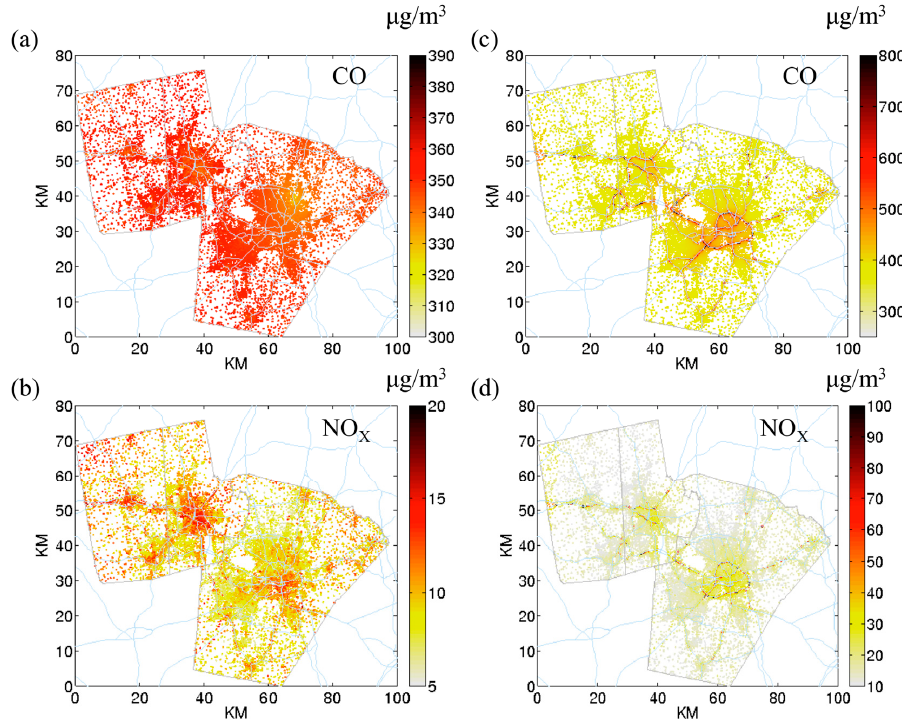
Figure 5. Indoor concentration of CO and NO x at 07:00 with ( a ) CO indoor STOK; ( b ) NO x indoor STOK; ( c ) CO indoor hybrid; ( d ) NO x indoor hybrid. The color bar represents concentration in µ g/m 3 (Note that the color scale is different for the four figures to emphasize the concentration ranges that vary by pollutant).